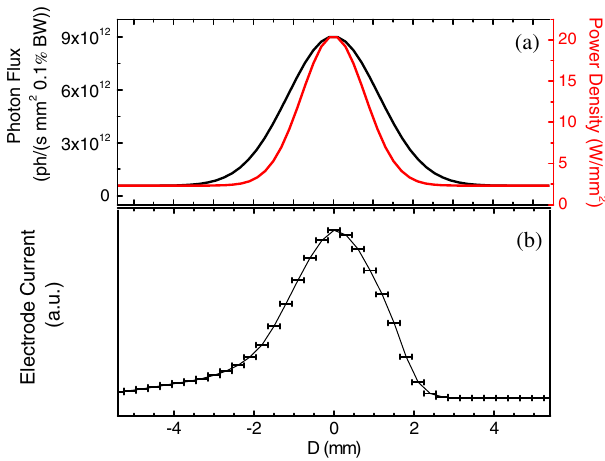
FIG. 7. (a) Calculation of the distribution of photon flux (black line) and power (red line) along the vertical direction as extracted from KARA ’ s bending magnet. (b) Signal of the current mea- sured at the photon cup ’ s electrode as a function of the collimator ’ s position. Both plots are referenced to KARA ’ s electron beam orbit (D ¼ 0